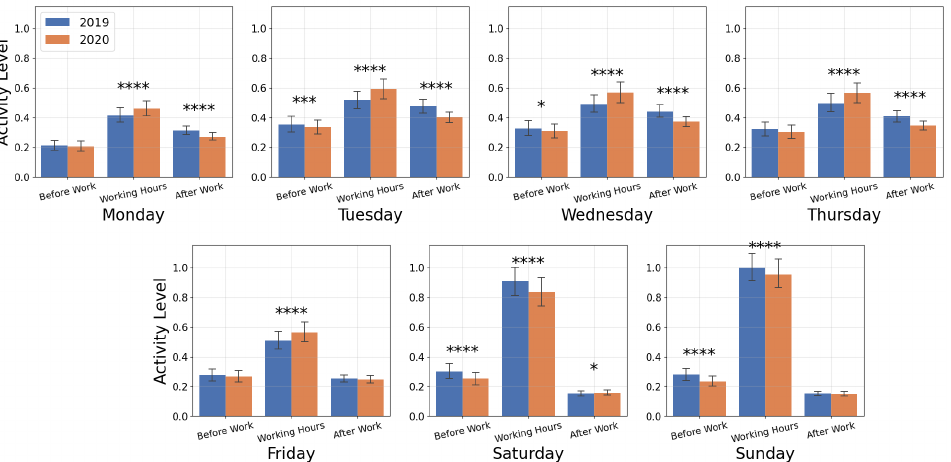
Figure 6. Normalized activity counts for the time periods before work (12 AM to 8 AM), during working hours (8 AM to 5 PM), and after work (5 PM to 12 AM). Significance with p < 0.05 is denoted by *, *** denotes p < 0.001, **** denotes p <